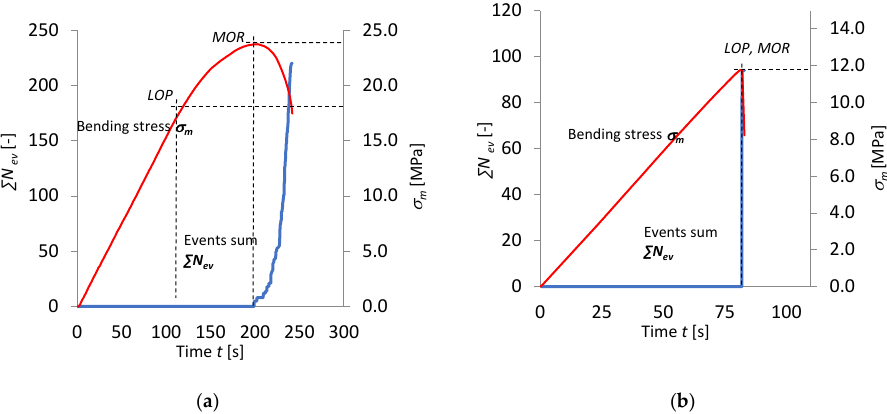
Figure 5. Bending stress σ m and events sum ∑ N ev versus time t for boards of: ( a ) series A R and ( b ) series A T